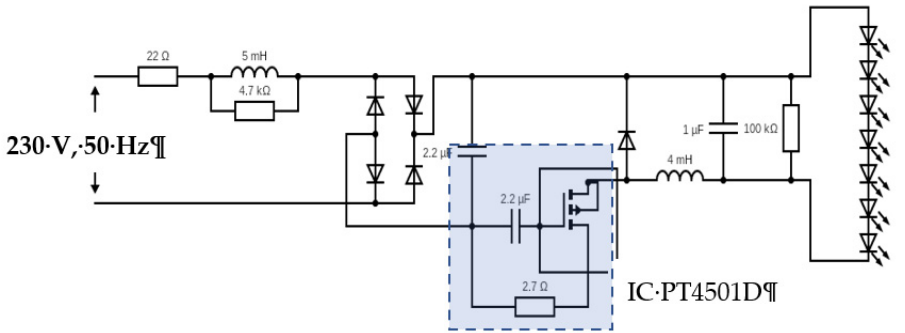
Figure 13. Simplified drawing of the circuit for Type B lamps.